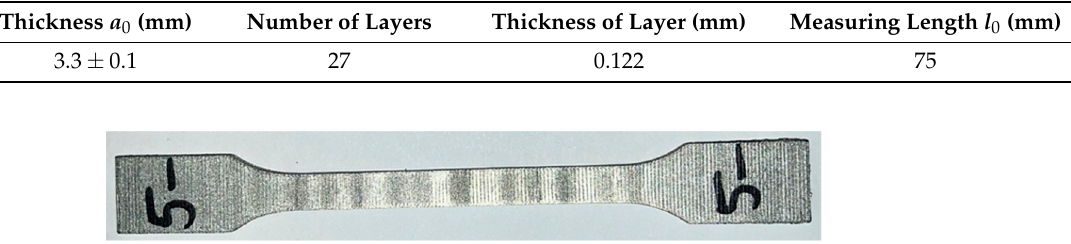
Figure 5. Elements printed from Ultrafuse 316 [25]. Figure 6. Example of tested samples (lamination angle 90 (cid:2925) ) Table 2. Dimensions of tested samples. Table 2. Dimensions of tested samples.